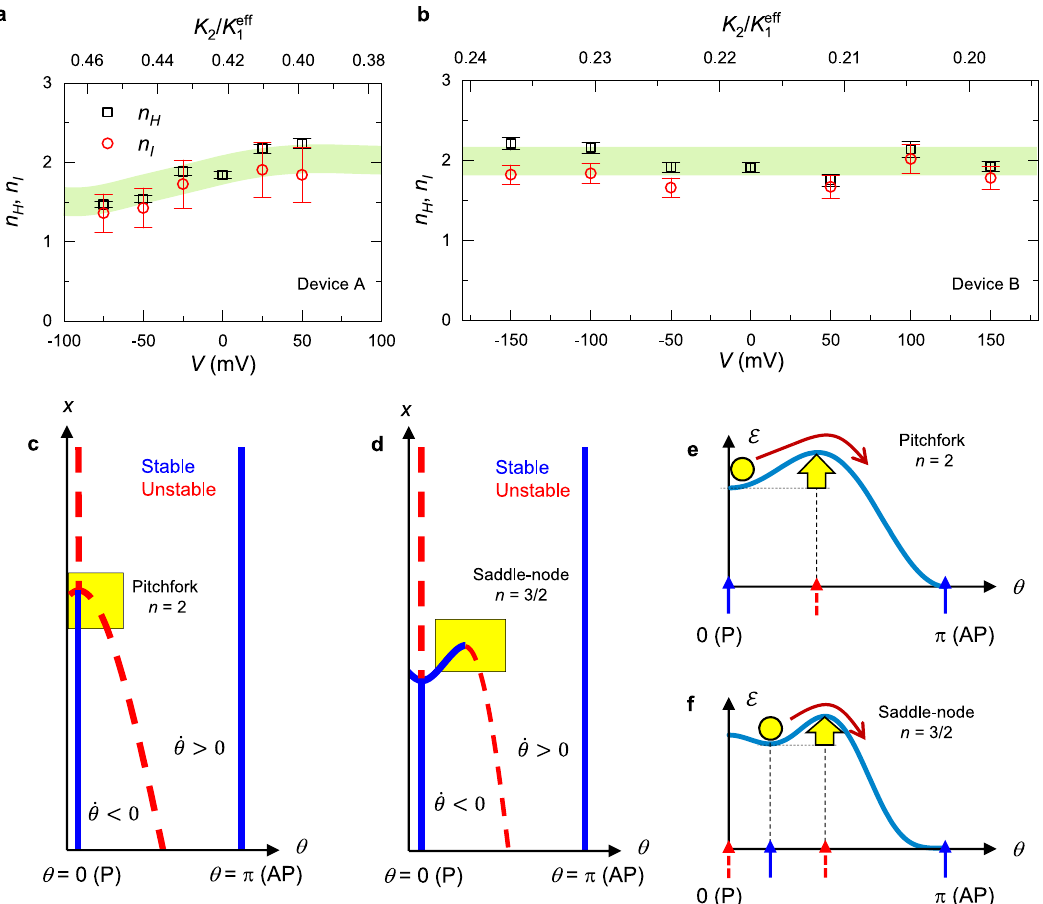
Fig. 6 Experimentally determined switching exponents n H n I . a , b Field- and current-induced switching exponents n H and n I as a function of bias voltage V for a device A and b device B. Error bars show standard error propagated from ferromagnetic resonance measurement and critical current measurement. The green band is a guide to the eye. c , d Bifurcation diagrams of the d θ /d t projected upon ( θ , x )( = ( θ , H ) or ( θ , I )) for c K 2 / K 1 eff < 0.25 and d K 2 / K 1 eff > 0.25, where K 1 eff , K 2 , θ , t , H , and I are the fi rst- and second-order effective anisotropy fi elds, polar angle of magnetisation vector, the time, perpendicular magnetic